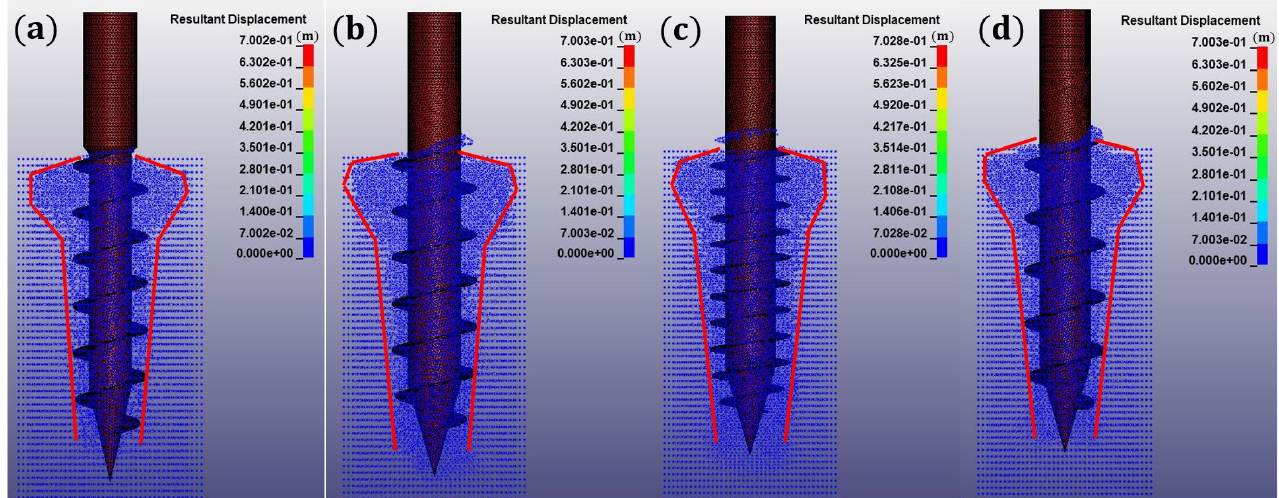
Figure 17. Soil displacement contour caused by the installation of the screw pile: ( a ) NT2, ( b ) NT3, ( c ) NT4 and ( d ) NT5.